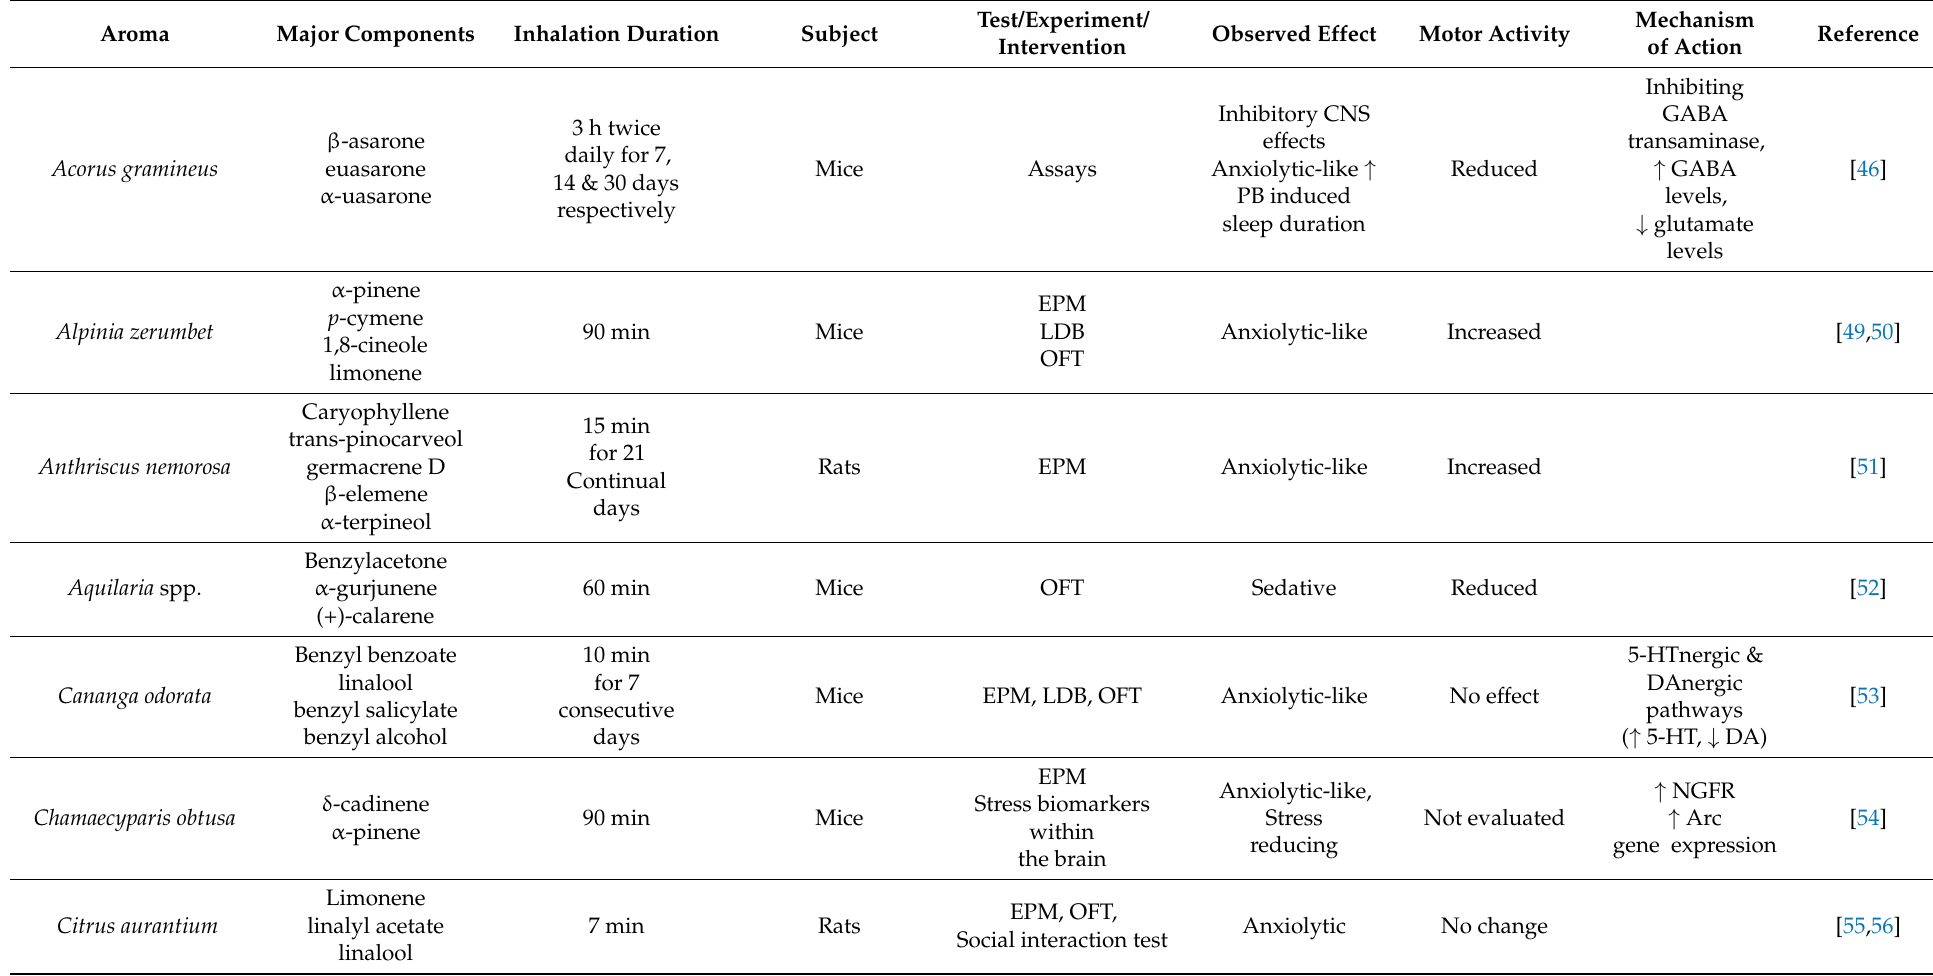
Table 1. Summary of studies on aromas associated with the GABAergic